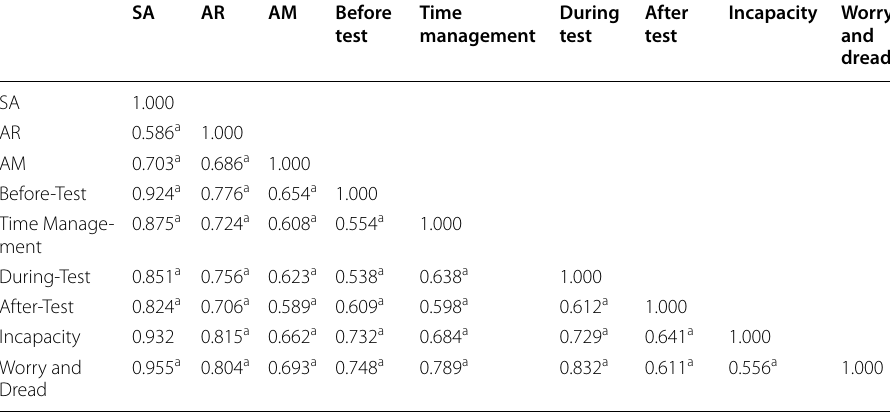
a Correlation is significant at the 0.01 level